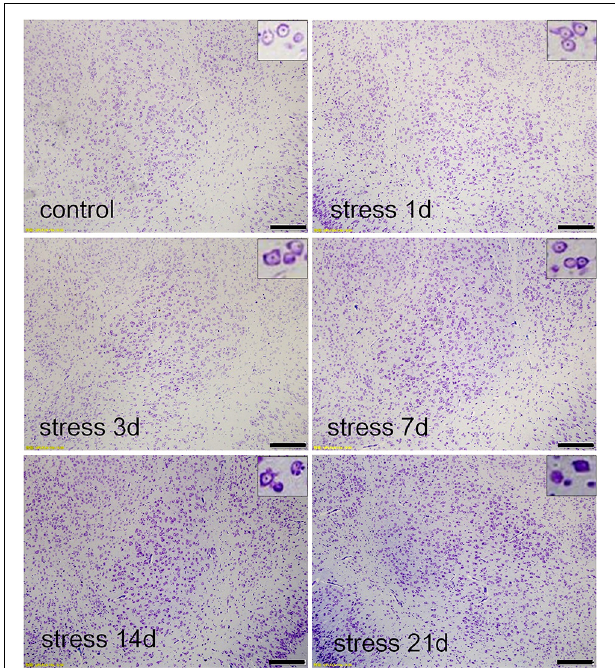
FIGURE 2 | Stress damaged the basolateral amygdala (BLA) neurons. Thionin staining in the control group, and stress groups at 1 day, 3 days, 7 days, 14 days and 21 days, respectively. High-power photomicrographs in the upper right corners are representative images showing neurons in panels. With increasing periods of stress exposure, Nissl bodies were not clear, neurophagy and pyknotic neurons were visible. Bars = 200 µ